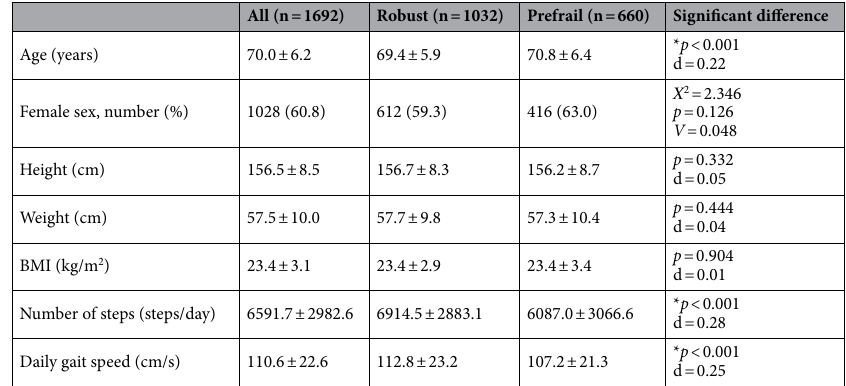
Table 1. Demographics and gait parameters of the robust and prefrail groups. Data are shown as means ± SDs. Unpaired- t tests or chi-square tests were conducted between groups. BMI = body mass index. * p < 0.05, d > 0.20.